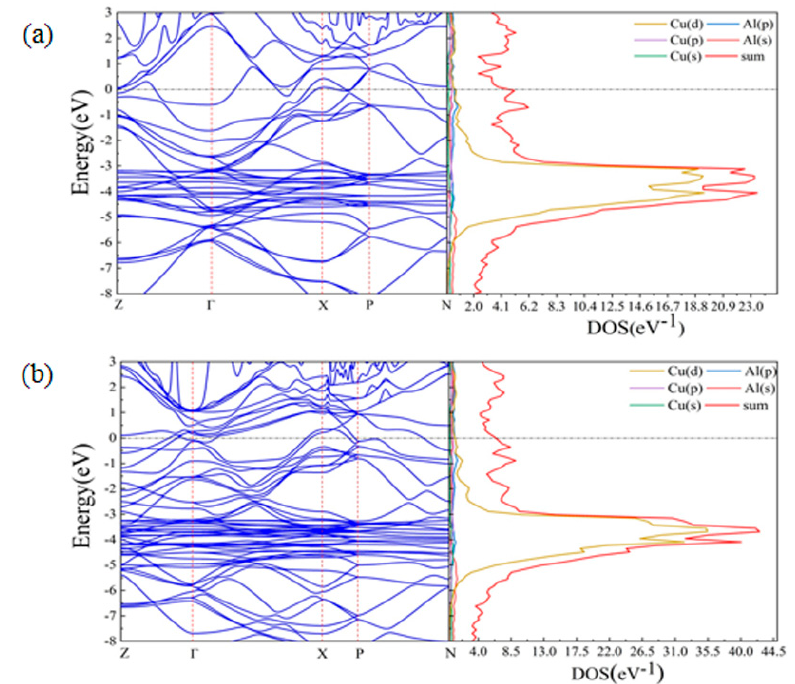
Figure 6. The electronic band structure and density of states of ( a ) the M1 phase and ( b ) the M2 phase.